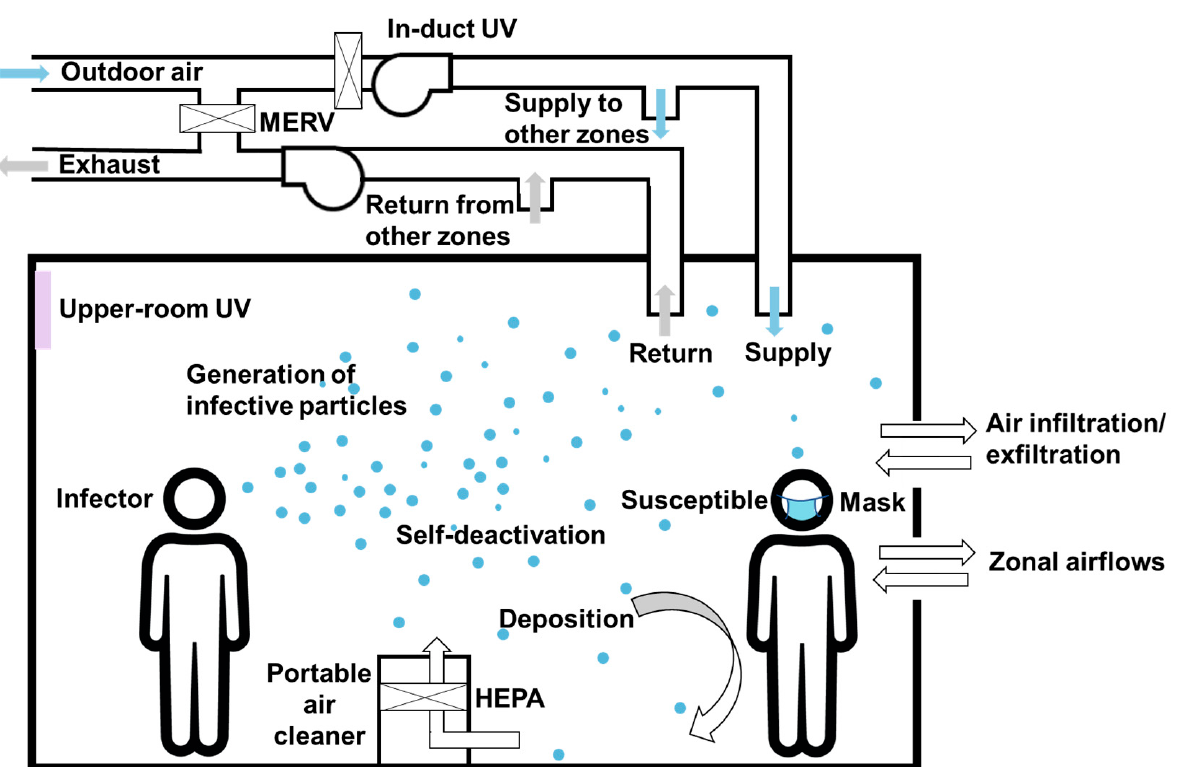
Figure 1. Mitigation strategies in multizone spaces for preventing airborne quanta transmission.